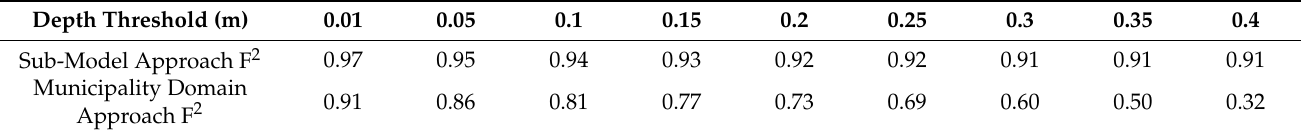
Figure 8. 2D flow domains determined by three approaches and their associated predictions based on MIKE FLOOD. ( a ) The full-basin domain determined from the full-basin high-resolution DEM. Notably, since the downstream receptor water body is involved as one part of the computation domains to collect the basin runoffs, the predictions on land areas can be considered as benchmark results, whereas the uniform closed boundary was adopted. ( b ) The sub-model domain, where the sub-model approach delineates the reduced domain accounting for the basin-wise 1D static flows. ( c ) The municipality domain determined from municipality borders. The red frame represents the extent of 2D model grids, the dotted frame defines the external modelling boundary, and the transparent spaces in-between two frames define the Nodata grid-cells. The grid-cells with the value of 100 define the excluded internal domain (i.e., buildings and non-spilling sub-impact zones) in MIKE FLOOD. Note: The figure to the right side of Figure 8a shows benchmark results zoomed to the same extent as the other approaches for easy comparisons. Table 1. F 2 values for the sub-model approach vs. the municipality domain approach. Depth Threshold